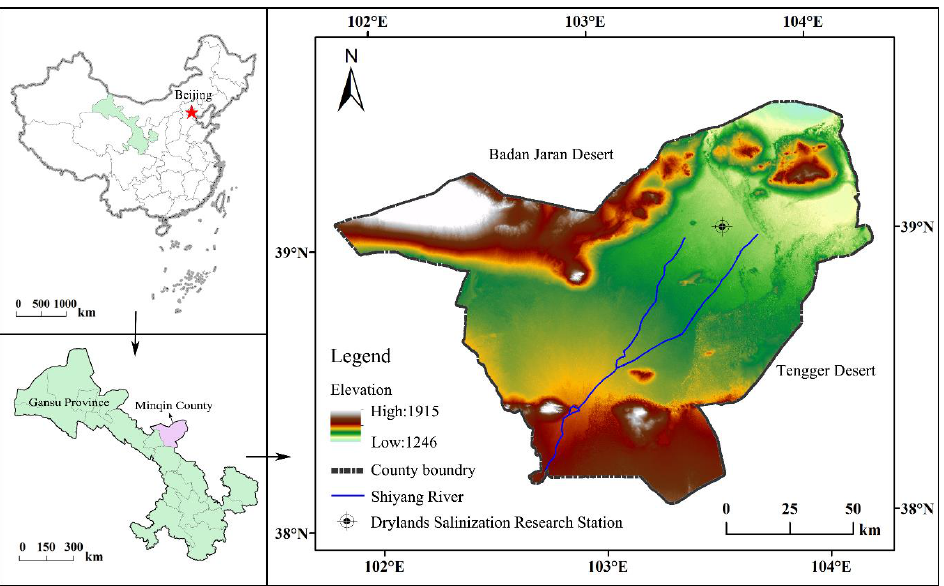
Figure 1. The location of the Drylands Salinization Station.